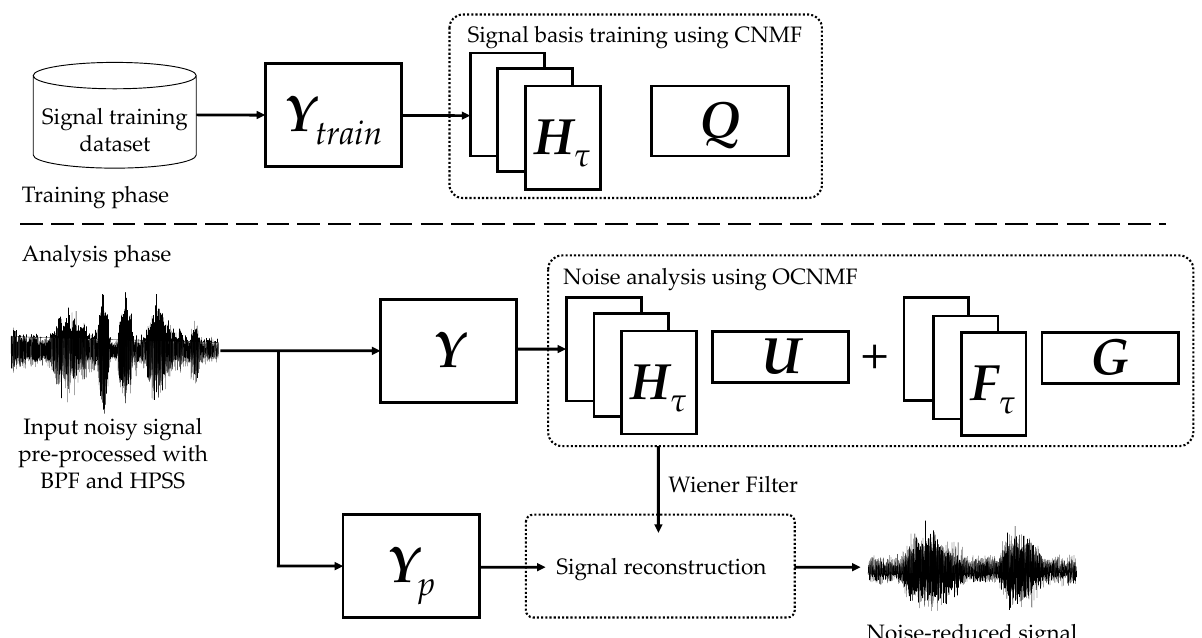
Figure 6. Proposed noise reduction framework based on orthogonality-constrained CNMF.